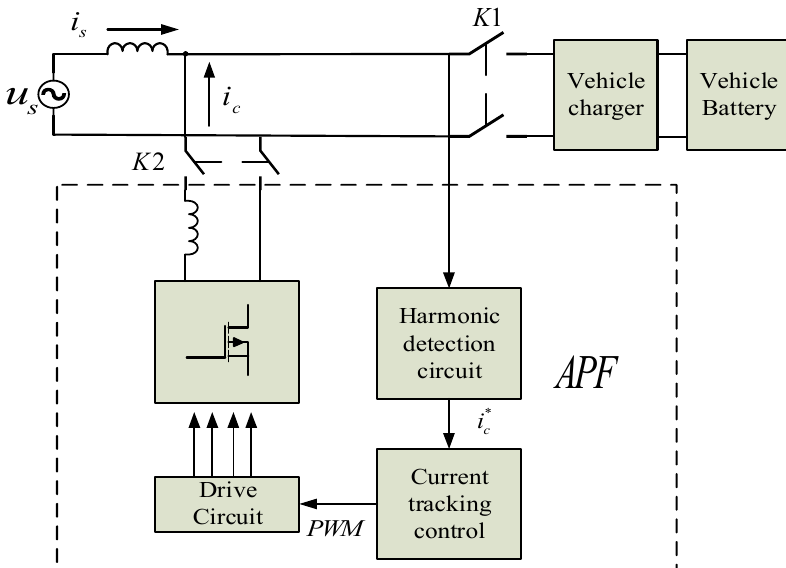
Figure 2. Single-phase PAPF working principle diagram.